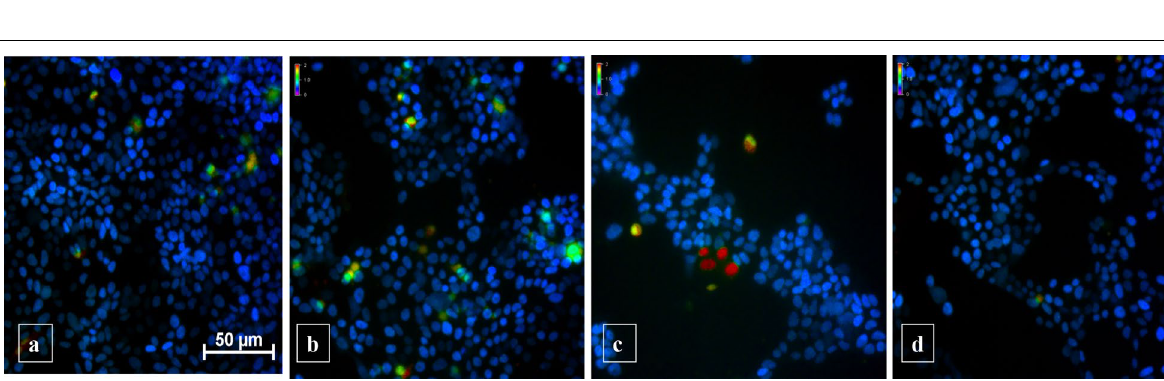
Fig. 6 Apoptosis study: a Control cell show low CFP/YFP Ratio. 24 h treatment of plant extract at b 10 µg/mL, c 18 µg/mL and d 30 µg/mL concentrations exhibited increase in caspase-3 activation and apoptosis, which was evident as increased CFP/YFP ratio levels in DLD SCAT3 NLS ratio metric